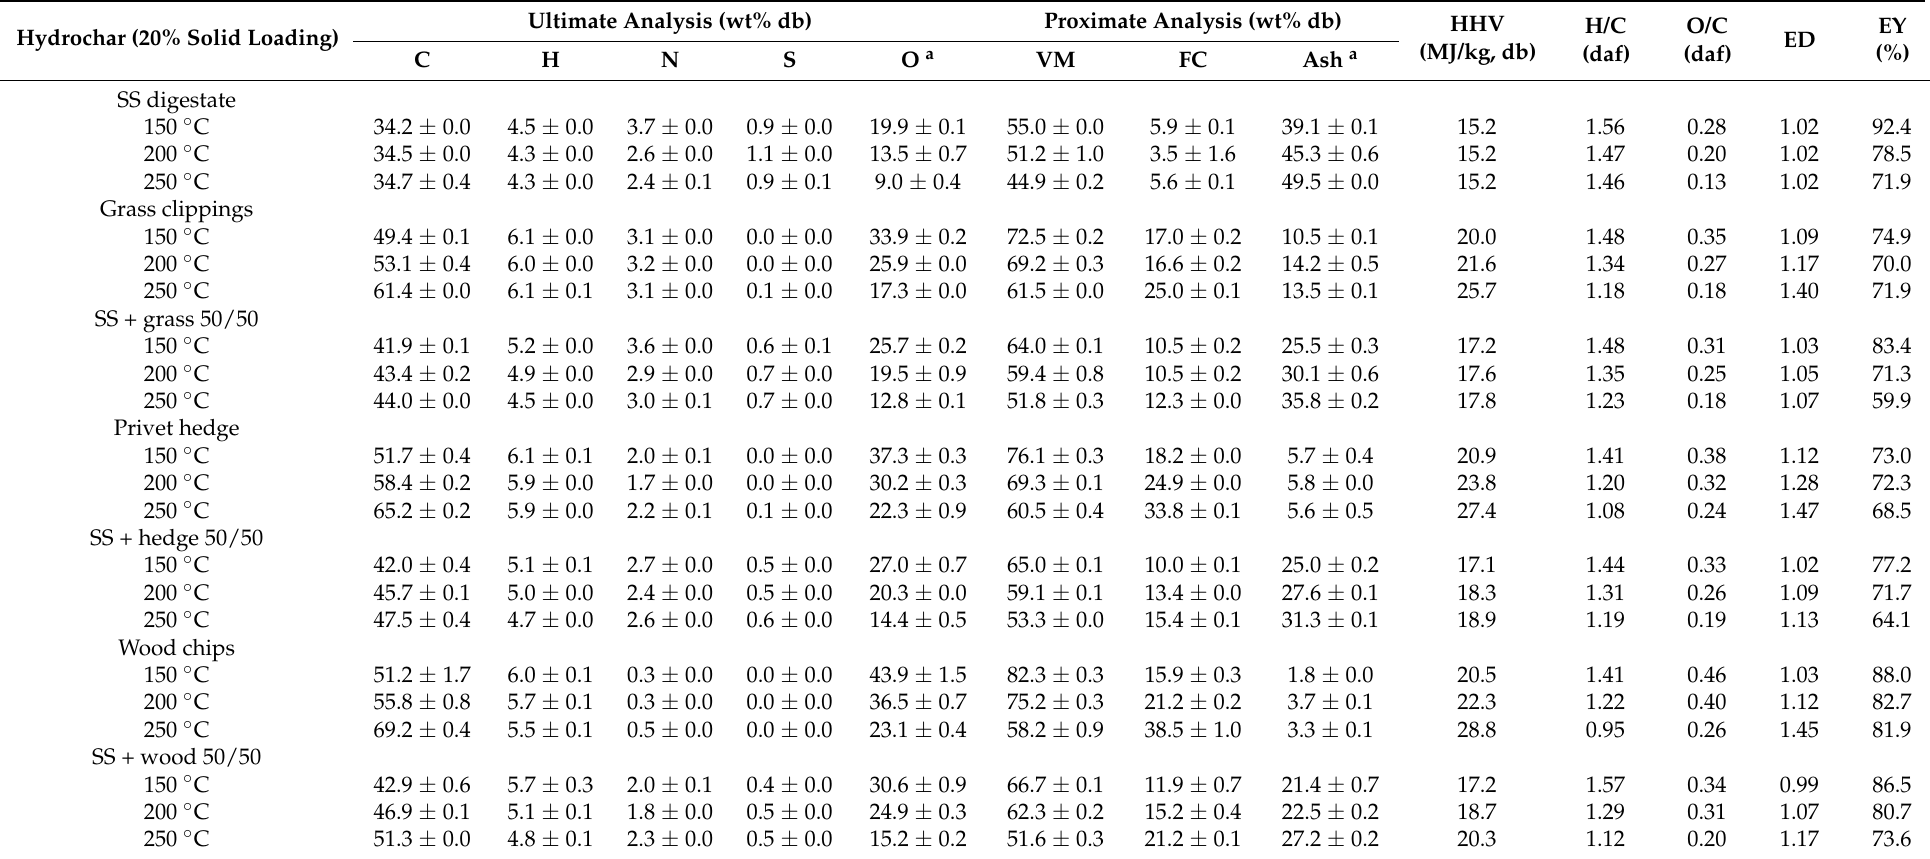
Table 4. Ultimate, proximate, and heating value of the hydrochars from SS, lignocellulosic biomass, and 50/50